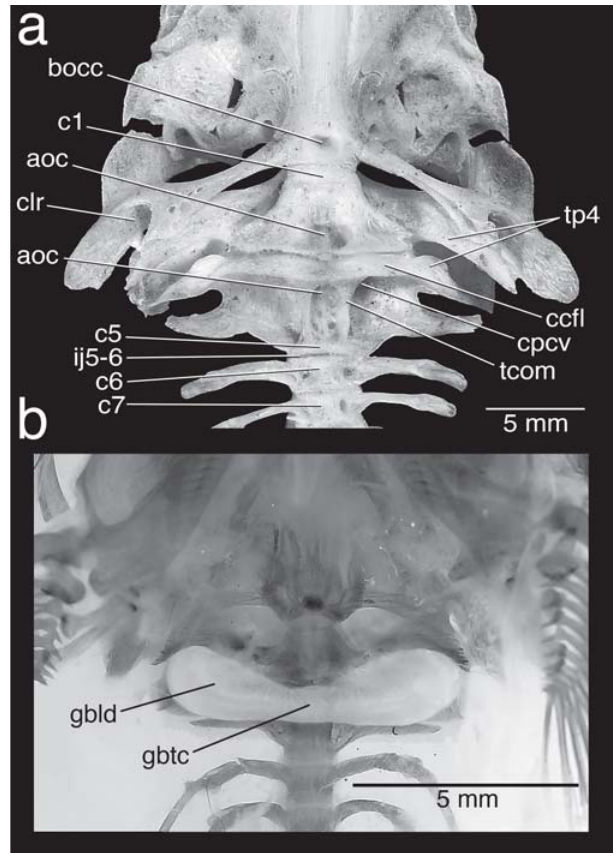
Fig. 1. a , Weberian complex, post-Weberian vertebrae, basioccipital region and upper bones of shoulder girdle of Megalonema cf. platycephalum , ANSP 178515. b , Weberian complex and gas bladder of M. orixanthum , ANSP 187450. aoc = bony aortic canal; bocc = basioccipital; ccfl = ventral flange of compound centrum; tcom = position of gas bladder tubular commissure posterior to ventral flange; clr = cleithral ring; cpcv = position of bony canal for passage of posterior cardinal vein; gbld = lateral distention of gas bladder; gbtc = transverse commissure of gas bladder; ij5-6 = typical intervertebral joint between c5 and c6; tp4 = ventrally incomplete bony capsules surrounding lateral lobes of gas bladder formed by deeply down-curved 4 th transverse processes of Weberian complex; c1, c5, c6, c7 = vertebrae designated by their ordinal